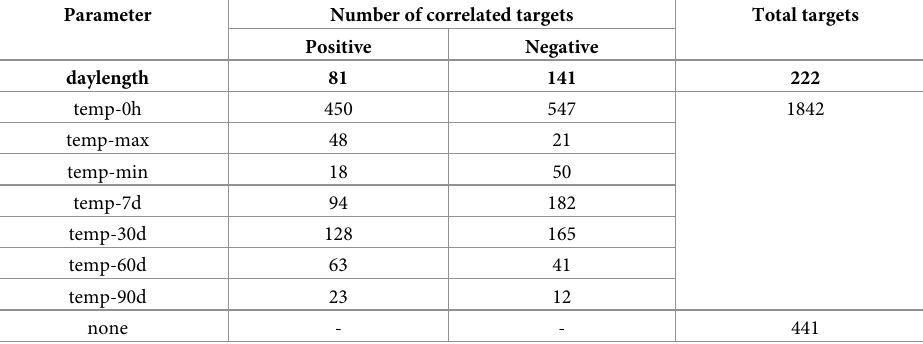
To identify the most effective meteorological parameter for each target, correlations between the meteorological parameters and expression levels of the 2,505 differentially expressed targets were calculated (S4 Table). Most of the differentially expressed targets showed the highest correlations with air temperature and day length, with 1,842 targets (73.5%) and 222 targets (8.9%), respectively (Table 2). The parameter air temperature at Table 2. Number of targets correlated with meteorological